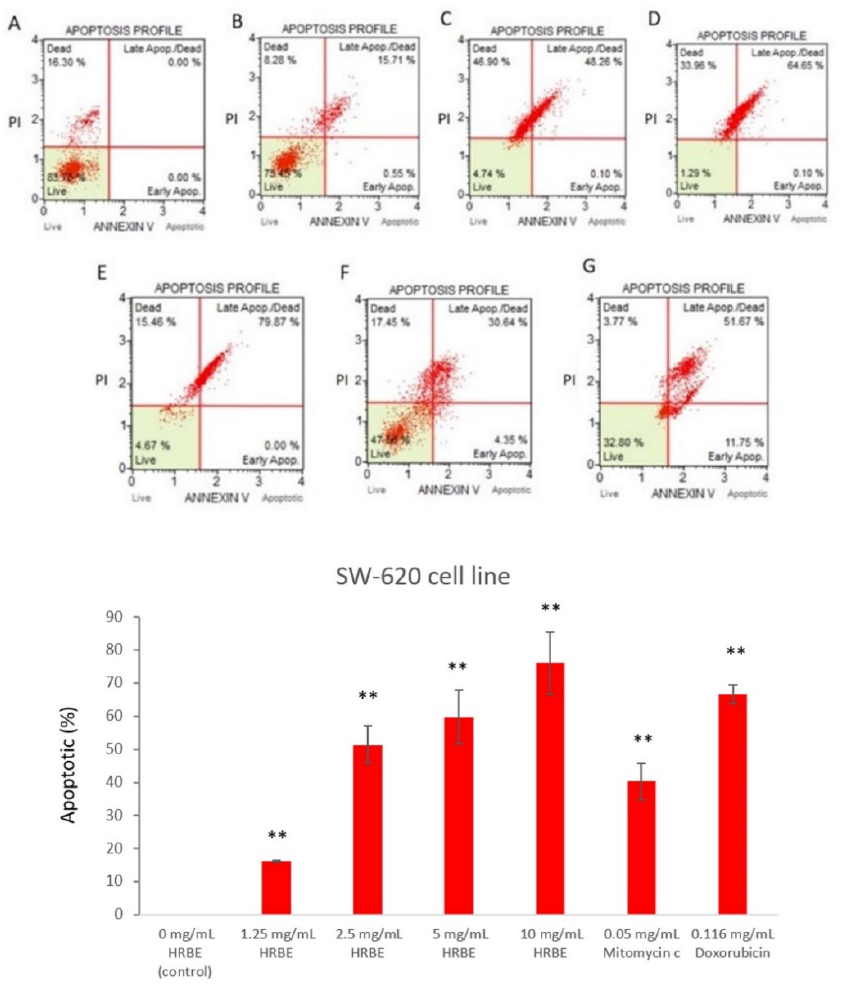
Figure 6. The percentage of cell apoptosis on SW-620 cells at 72 h indicated by Annexin V and flow cytometry after being treated with 0 mg/mL, considered as negative control ( A ), 1.25 mg/mL ( B ), 2.5 mg/mL ( C ), 5 mg/mL ( D ) and 10 mg/mL ( E ) compared to positive control groups treated with 0.05 mg/mL mitomycin C ( F ) and doxorubicin 0.116 mg/mL ( G ). Data are represented by the mean ± SD. Statistical analysis was performed using student’s t -test to compare each concentration with the control group (0 mg/mL) (**, p ≤ 0.01).